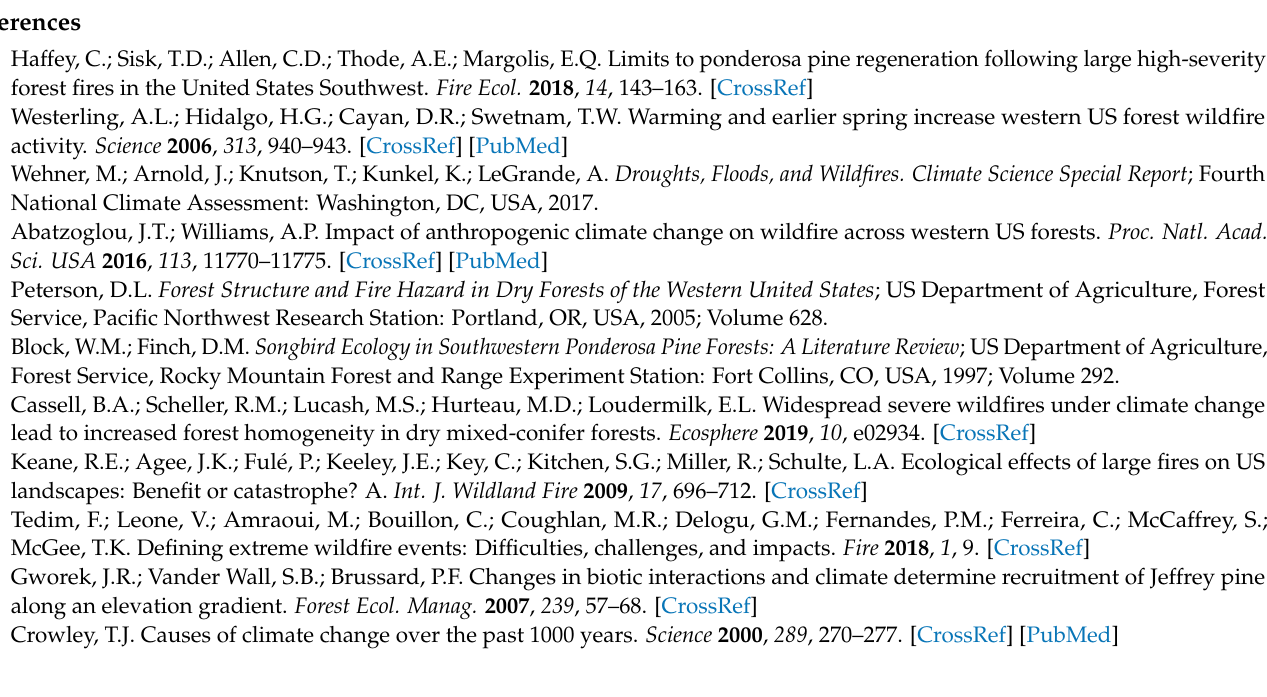
experiment; Figure S3: Pictures of the tested samples; Figure S4: (a) Jeffrey pine duff, (b) DRI combustion chamber in use, and (c) combustion in progress (tube on the left is part of the fuel delivery